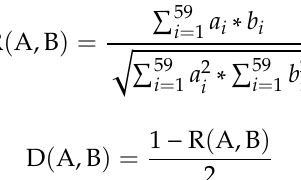
Table S1. Host, country, and date of HA and NA sequences used in this study. Table S2. Nucleotide composition of HA and NA sequences and relevant plotting